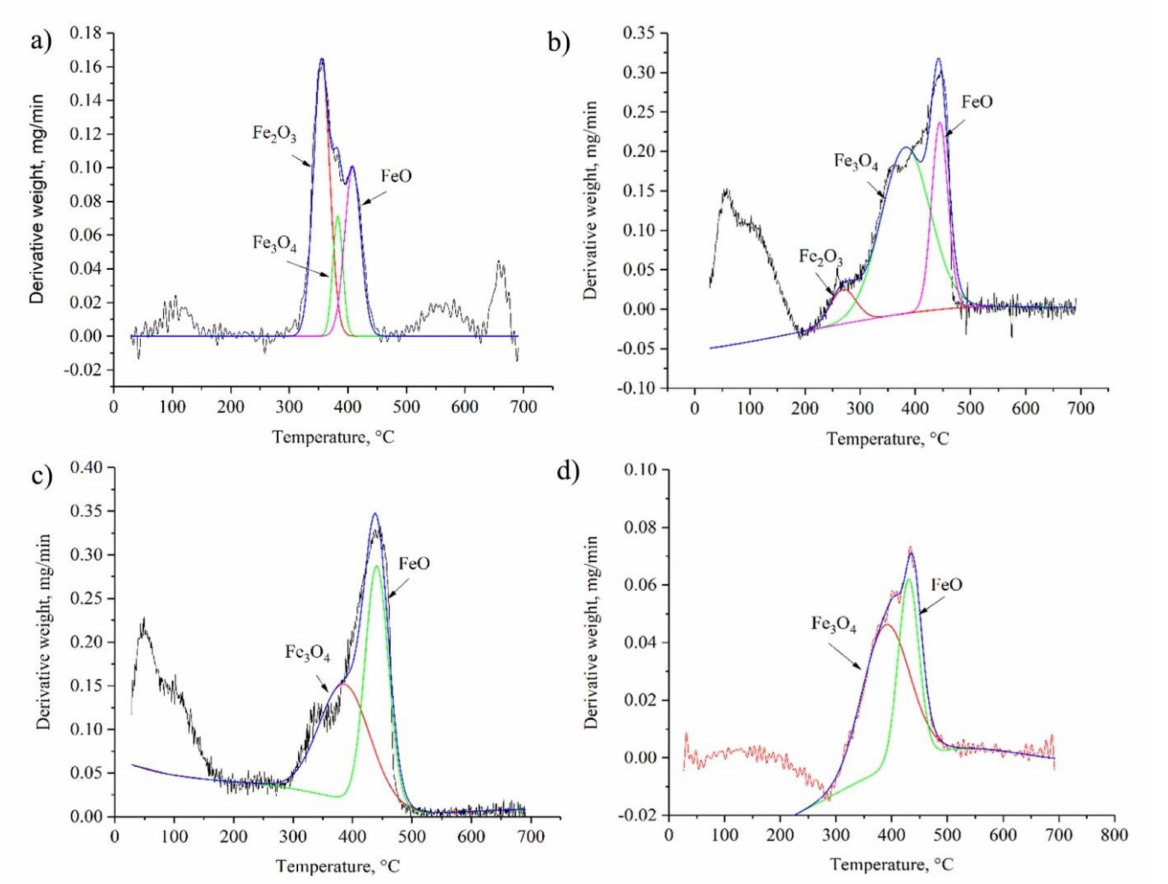
Figure 8. Split TGA curves: Fe(n–FeOOH) ( a ); Fe(n–Fe 2 O 3 _01) ( b ); Fe(n–FeO_02) ( c ); m–Fe_01 ( d ).